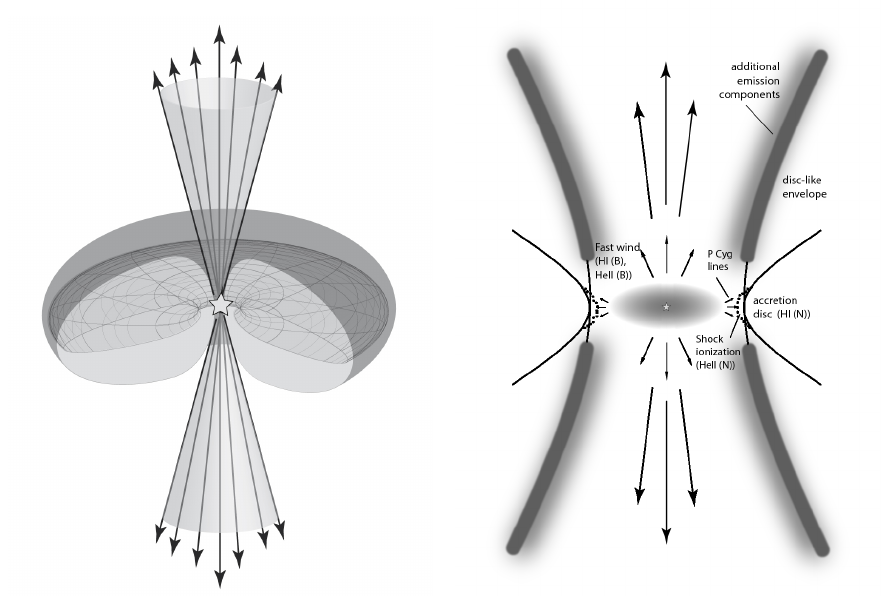
Fig. 1. Left panel . Schematic model of the region around the hot component during recurrent strong outbursts. Right panel . The same but in the plane perpendicular to the orbital plane where the emission regions are shown. From Tomov et al. (2010,